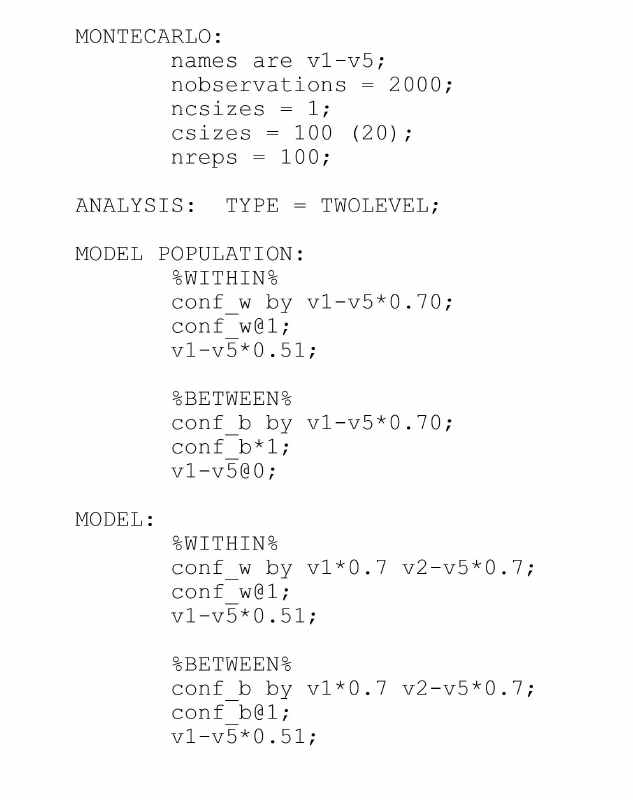
Figure A1. Mplus input file corresponding to the first row in Table